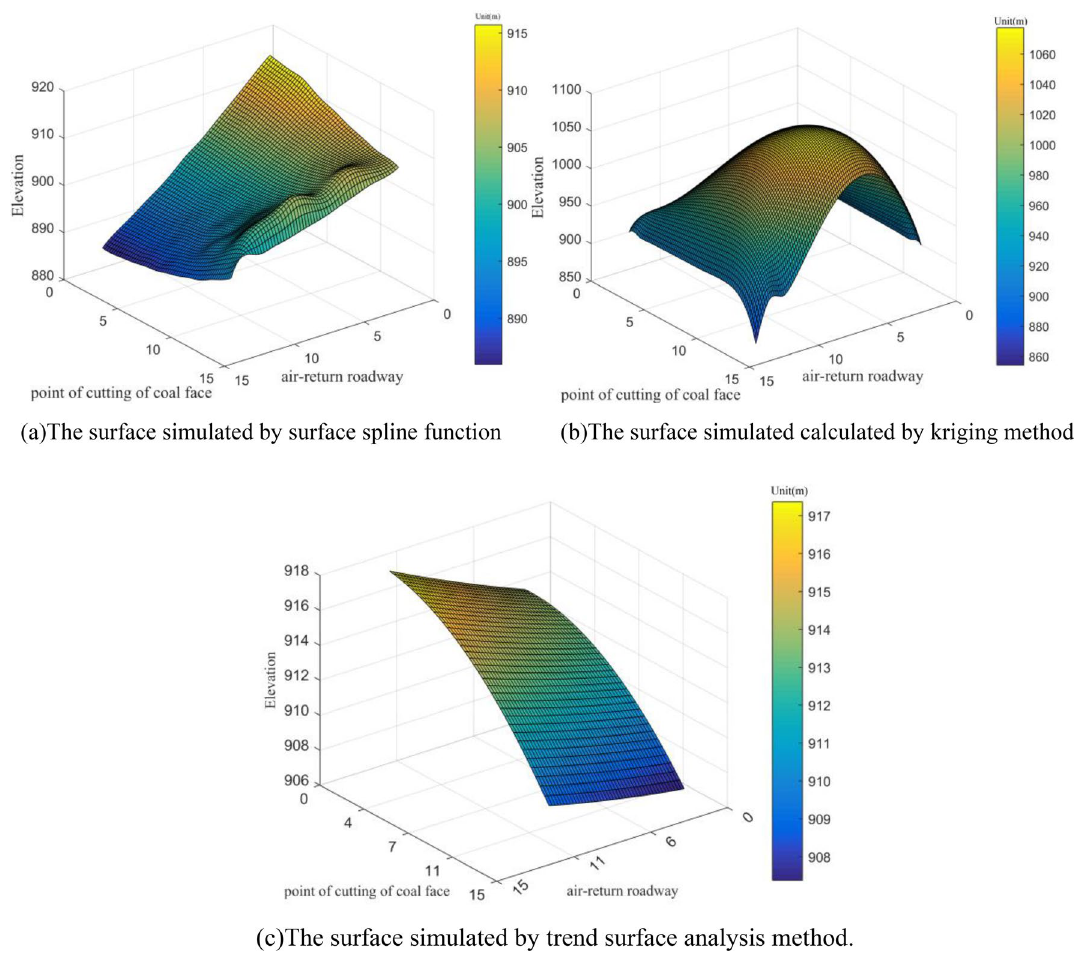
Figure 7. The spatial distribution of coal seam floor (enclosed by blue rectangle in Fig. 6) predicted by surface spline function, kriging method and trend surface analysis